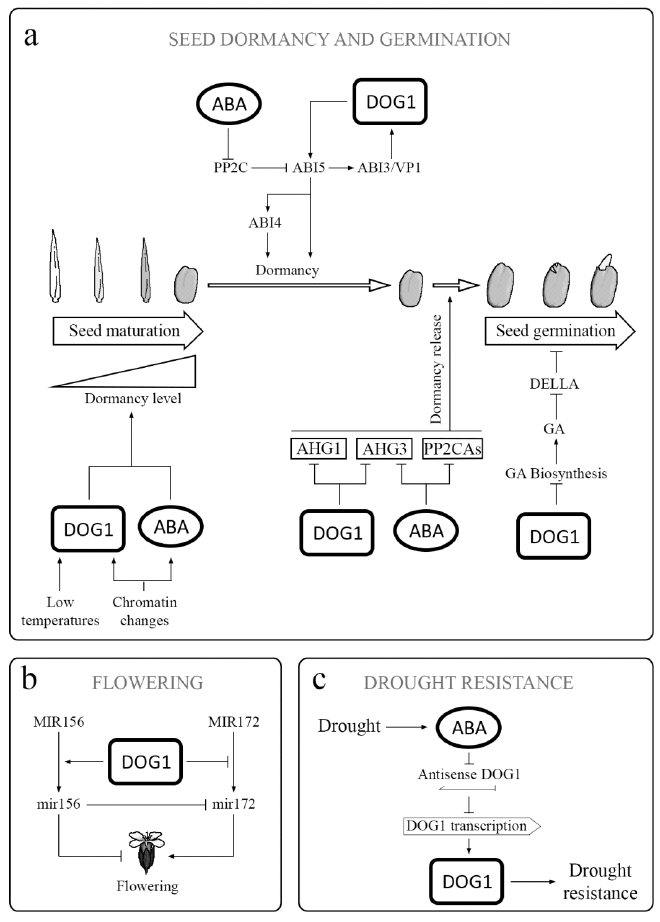
Figure 5. DOG1 in different physiological processes: ( a ) DOG1 has an influence on several genes involved in ABA signaling, including ABI3 and ABI5. Thus, it acts together with ABA in the regulation of the acquisition, maintenance, and release of PD. DOG1 also inactivates AHG1 and AHG3, which are the key negative regulators in ABA signaling. The inactivation of AHG1 and AHG2 results in release of PD. Additionally, DOG1 reduces the GAs biosynthesis during germination. ( b ) DOG1 participates in the regulation of flowering by influencing the transition from primary MIR156 and MIR172 to active miR156 and miR172 through an effect on expression of genes involved in miRNA processing. Both active miRNAs are regulators, not only of flowering but also of PD and seed and seedling development. ( c ) Under drought conditions, the ABA content increases. The expression of DOG1 enhances the drought tolerance in vegetative tissues, and asDOG1 transcription is ABA repressed. asDOG1 acts as a negative regulator of DOG1 transcription.